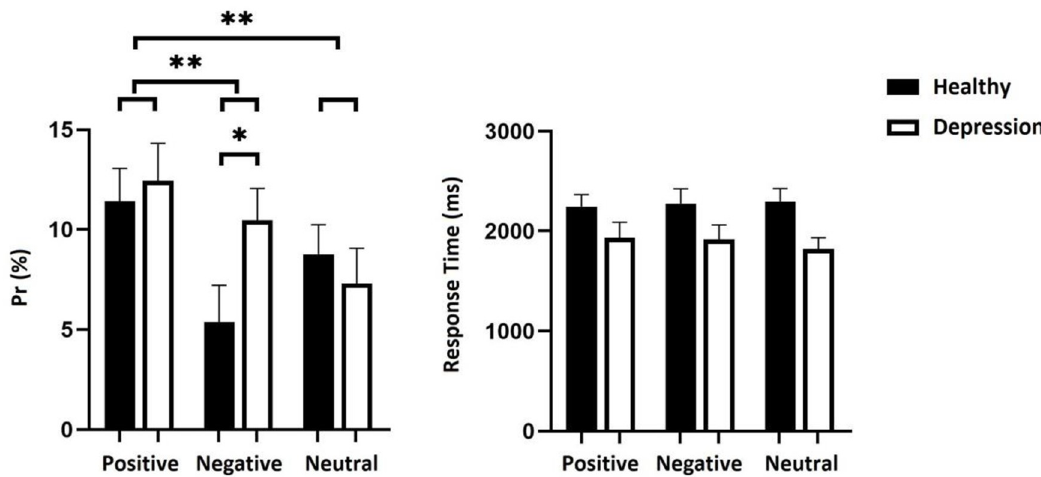
Fig 1. Pr and mean RT in Experiment 1. Error bars represent standard errors. � p < 0.05; �� p < 0.01; ��� p <